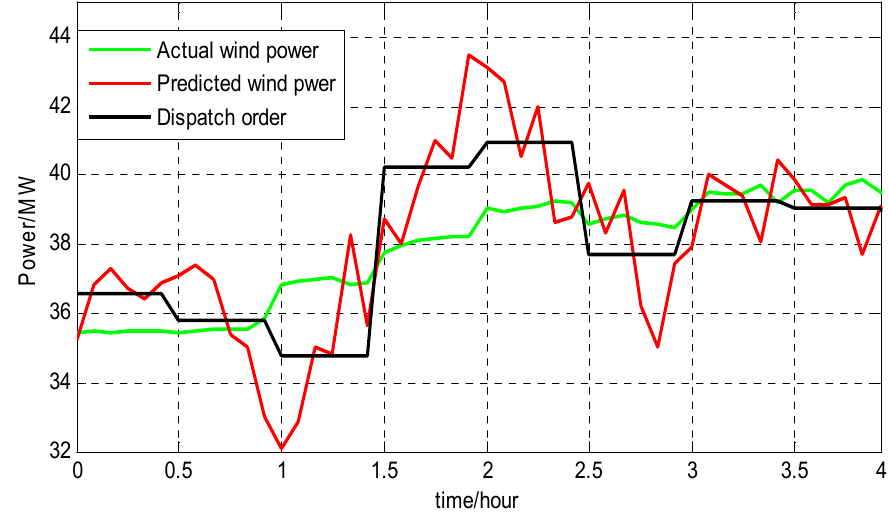
Figure 2. Schematic diagram of selecting dispatching order.